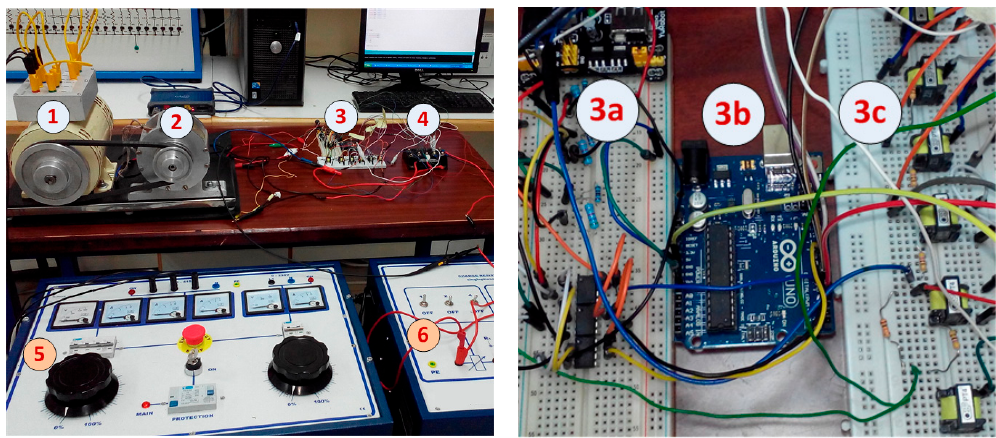
Figure 19. Experimental test rig; (1) Three-phase driving motor, (2) AFPMA, (3) controller circuit,